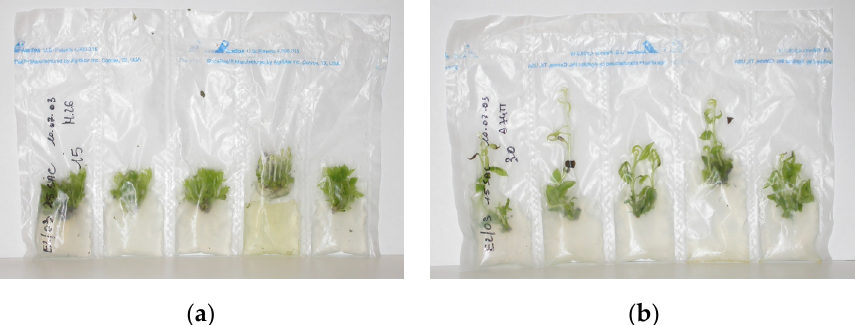
Figure 1. Slow growth storage of apple ( a ) and pear ( b ) shoots in Starpac Pac ™ (Tokyo, Japan) bags (Photos by Benelli